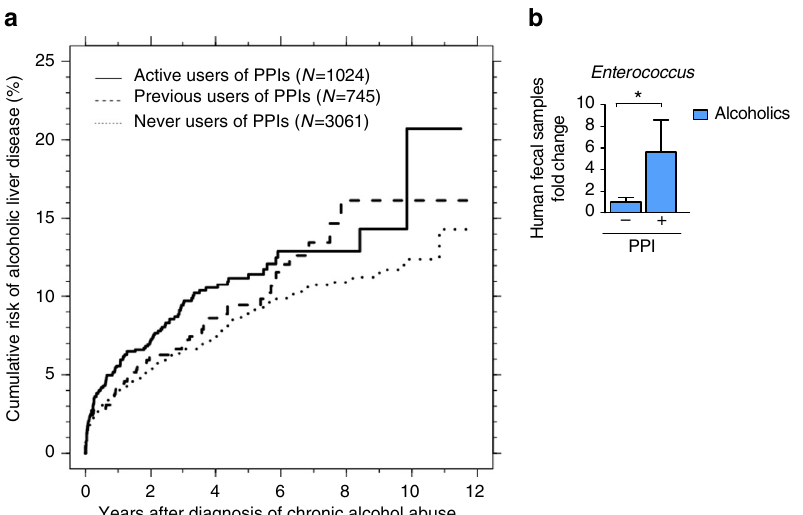
Fig. 9 PPI treatment increases the risk of liver disease in chronic alcoholics. a Cumulative risk of ALD based on use of PPIs. A Cox regression model was used to compare risk among active, previous, and never users. b Fecal amounts of Enterococcus in chronic consumers of alcohol taking PPIs ( n = 3) and not taking PPI ( n = 8). Results are expressed as mean ± s.e.m. For a , a Cox regression model was used to compare risk among PPI users in a cohort of alcohol- dependent patients.For b , signi fi cance was evaluated using Student t- test. * P < 0.05